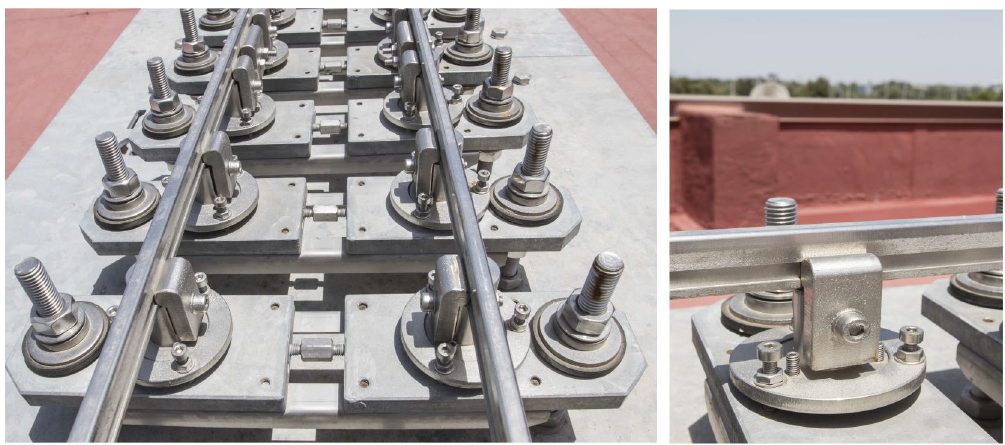
Figure 12. Support mechanisms (left) and rail to support mechanism clamp (right). Photographer: Ludivine